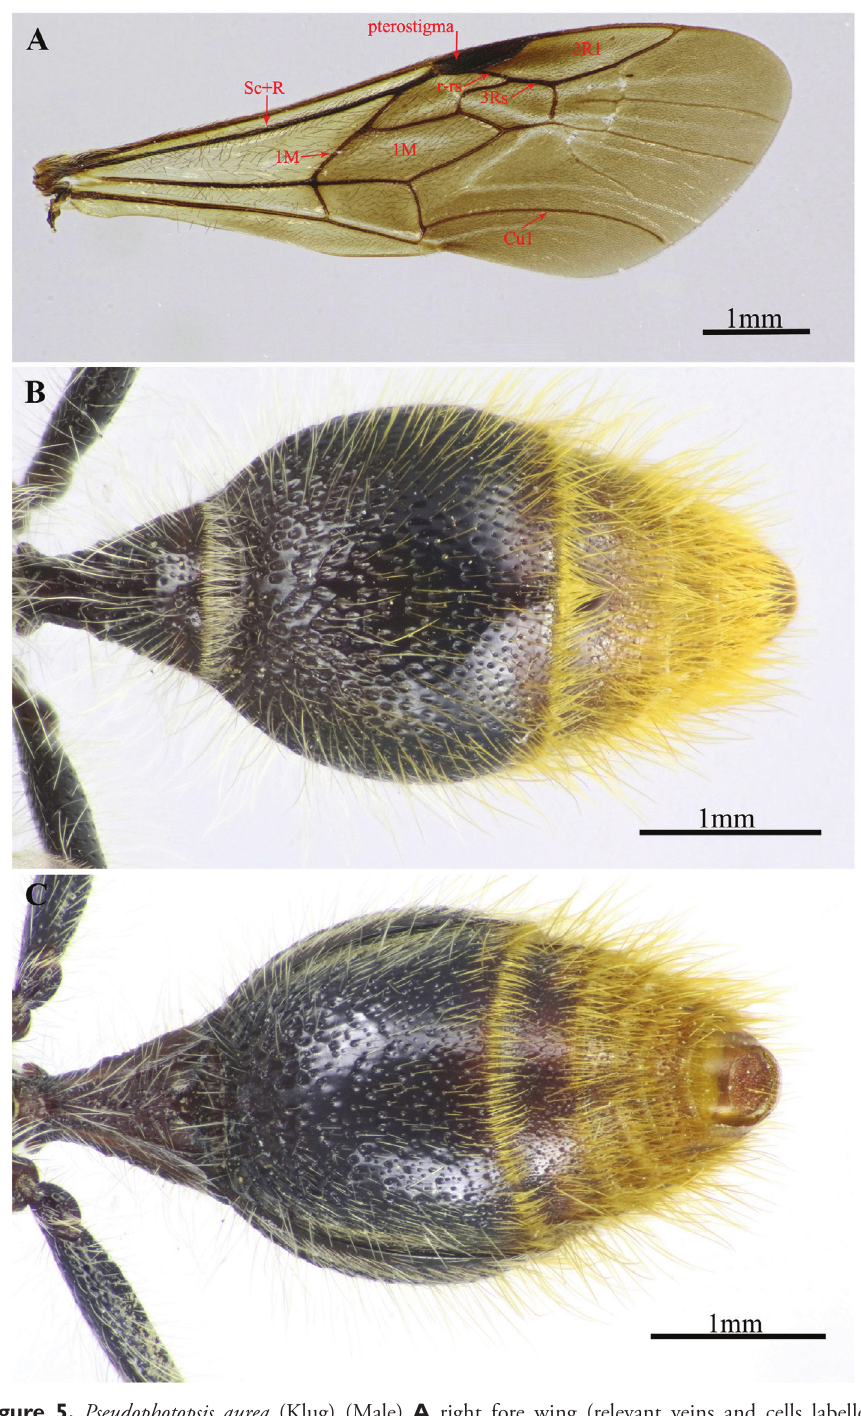
Figure 5. Pseudophotopsis aurea (Klug) (Male) A right fore wing (relevant veins and cells labelled) B, C metasoma, dorsal and ventral views,